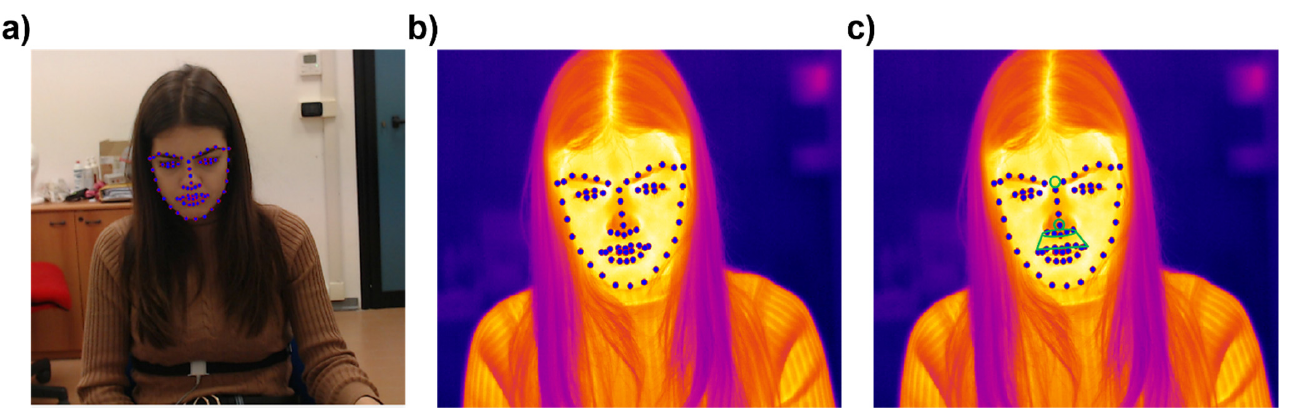
Figure 3. Thermal tracking pipeline. ( a ) Facial landmarks’ automatic recognition in the visible domain. ( b ) Facial landmarks’ identification on the corresponding IR images. ( c ) ROI identification with respect to the facial landmark. The green circles correspond to the four facial regions tracked, which are: the nose tip, nostrils, perioral, and corrugator area.